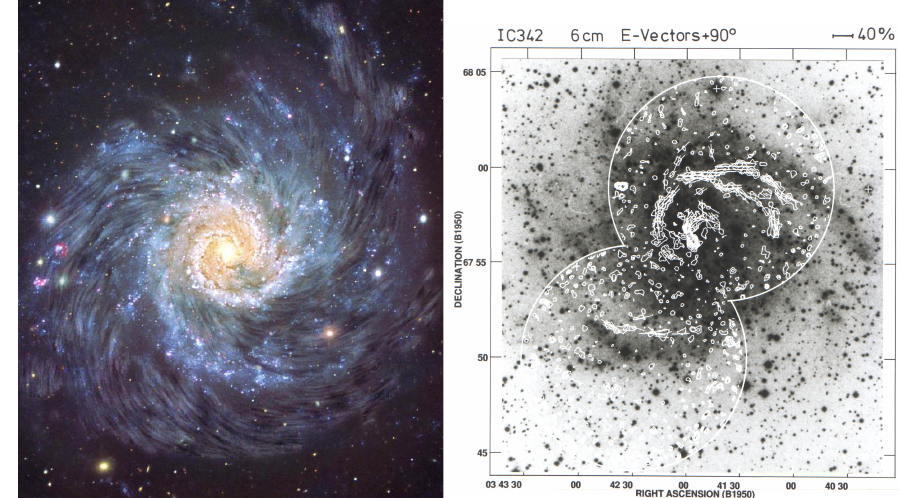
Figure 1. ( Left ) Polarized intensity of the spiral galaxy NGC 628 at λ 9.7 cm (3.1 GHz) from JVLA observations with a resolution of 18 (cid:48)(cid:48) HPBW with the magnetic fields illustrated as flow lines, overlaid on an optical image plus H α from Calar Alto Observatory [17]. ( Right ) Polarized intensity contours of IC342 at λ 6.2 cm (4.8 GHz) from VLA observations with a resolution of 16 (cid:48)(cid:48) HPBW, overlaid on a POSS optical image. The vectors give the apparent magnetic field orientation (i.e., not corrected for Faraday rotation)